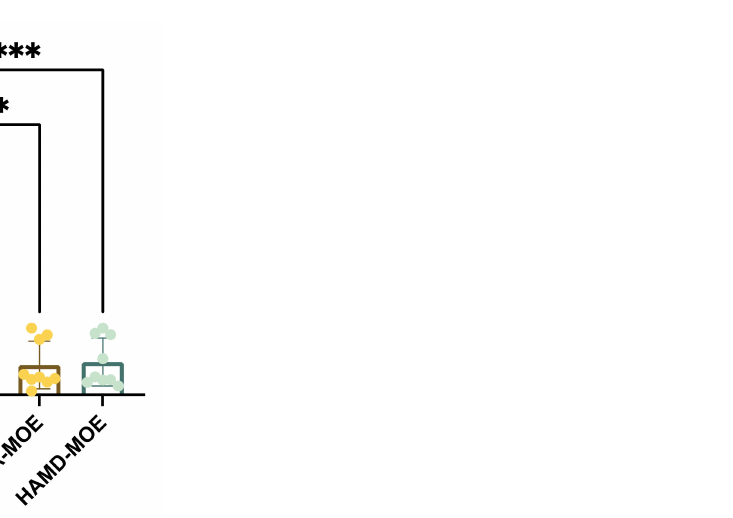
Figure 4. Effects of MOEs on biofilm formation: The EA biofilm was measured by OD 600 and presented as the percentage compared to the control. Data are the mean of 3 independent experiments performed on triplicate (mean +/ − standard deviation), and values are represented as a percentage; **** p -values < 0.001.